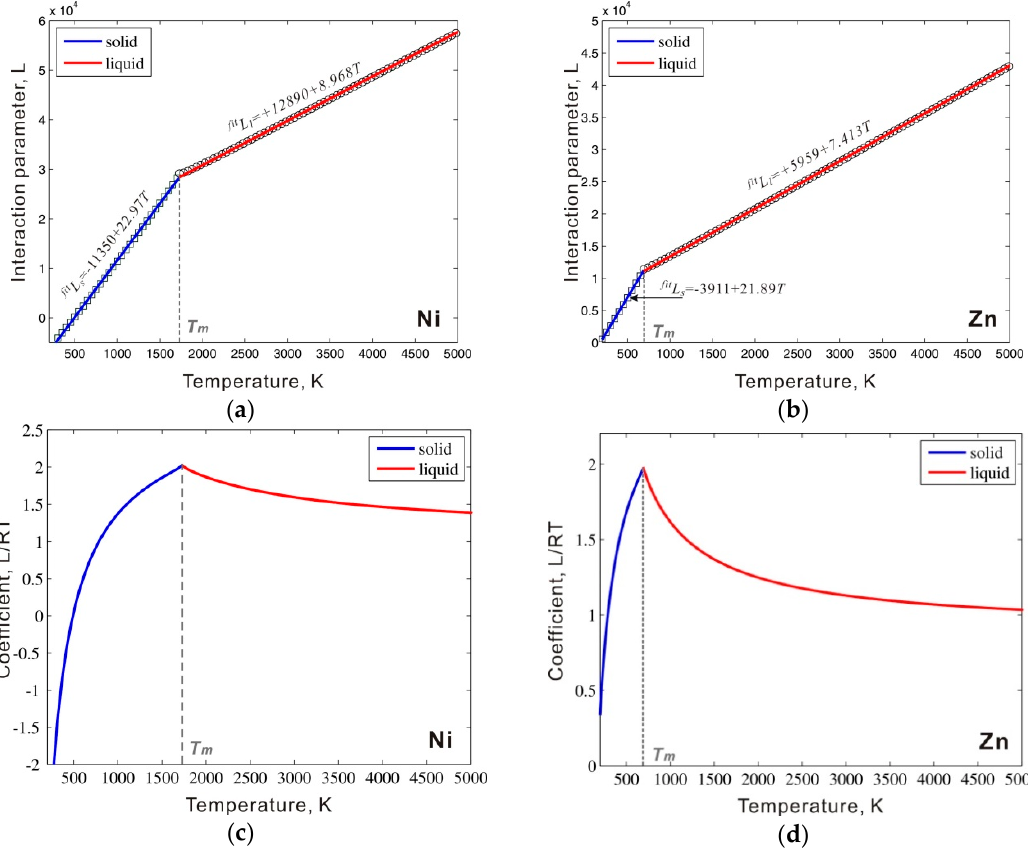
Figure 3. Critical interaction parameters ( L crit ) in the metastable bcc_A2 phase between a thermal vacancy along with the fitted interaction parameters (solid line) for ( a ) Ni and ( b ) Zn; the calculated coefficient L / RT in ( c ) Ni and ( d ) Zn.